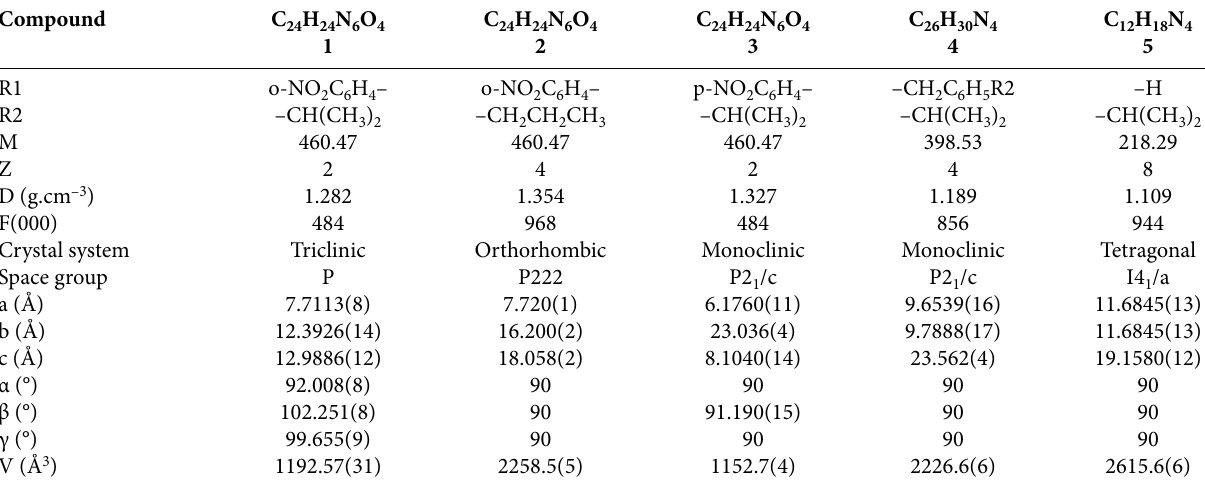
Table 1. The main experimental crystal parameters of 3,3’-bipyrazole compounds 1-5 Compound